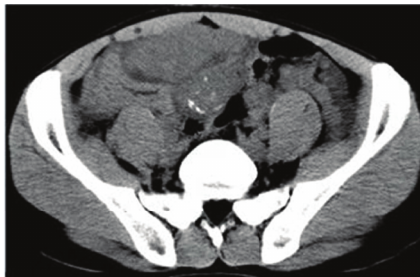
Figure 1: Abdominopelvic CT scan revealed diffuse multiple soft- tissue masses in peritoneal and mesenteric surfaces.